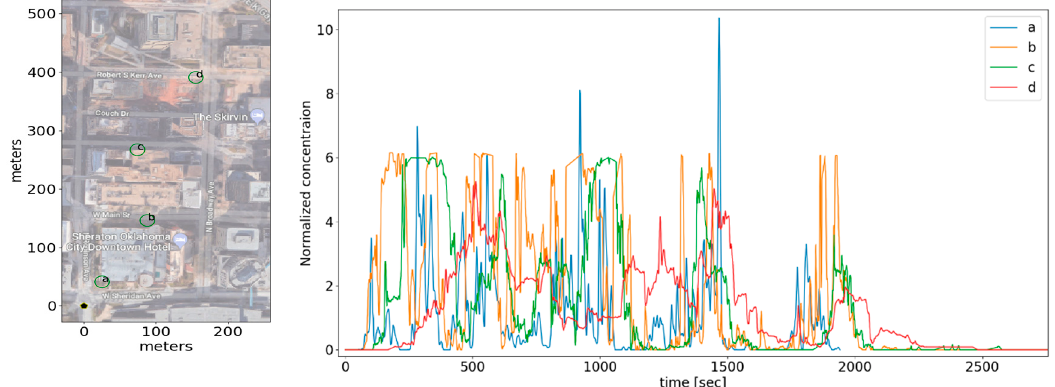
Figure 1. Concentration signals observed in JU03 field campaign (IOP 188, release 5). The left panel shows the continuous source (black pentagon), and four selected fast gas analyzers (green circles, labeled a, b, c and d), coordinates are given in meters with the source at the origin. The right panel presents the corresponding concentration signals.